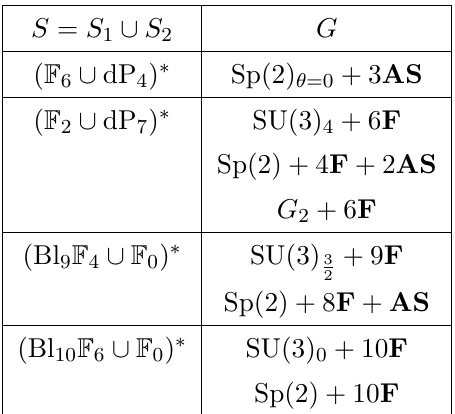
Table 3. Rank 2 geometries with maximal M . In the above table, S is the rank 2 K(cid:127)ahler surface, while G is the corresponding gauge theory description. These geometries denoted as ( shrinkable and correspond to 5d KK